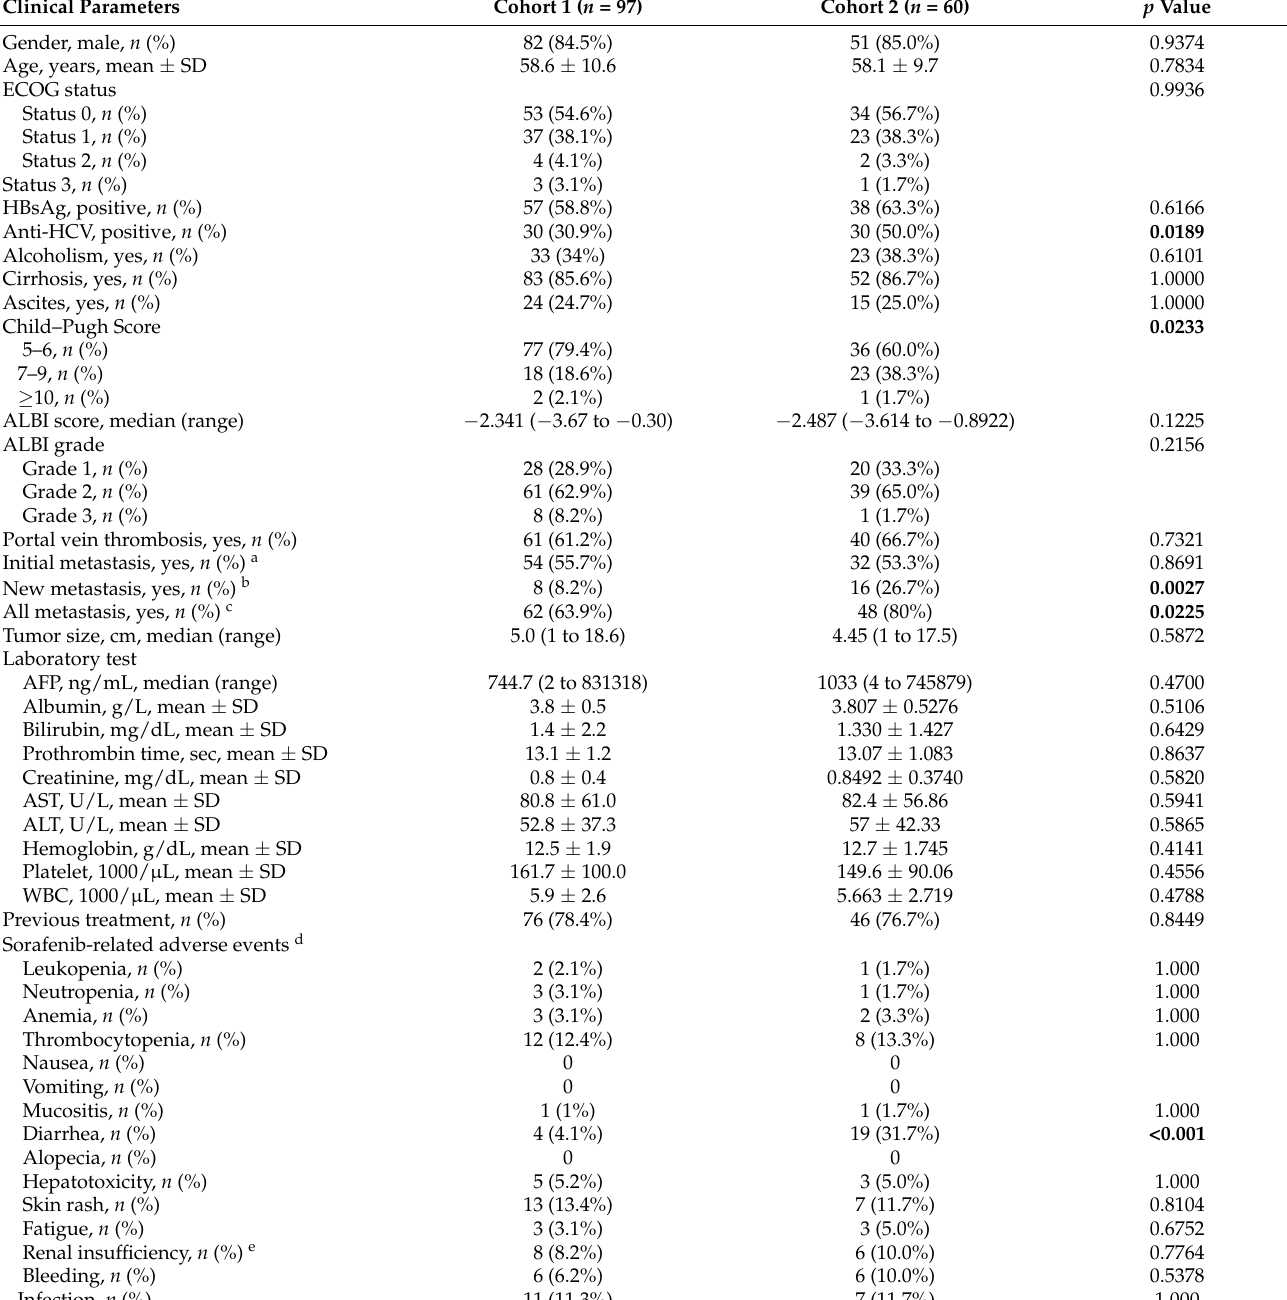
Table 1. Basic clinical data of cohort-1 ( n = 97) and cohort-2 ( n = 60)